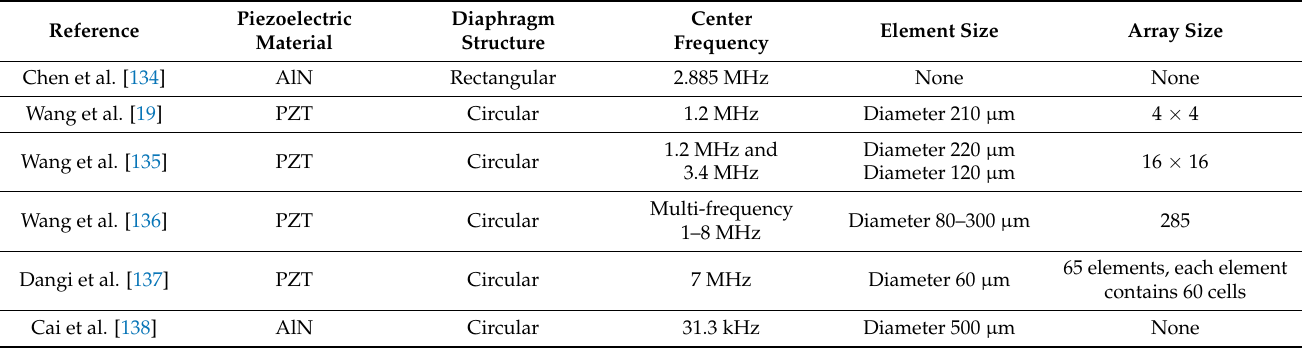
Table 5. A summary of PMUTs for photoacoustic imaging applications.